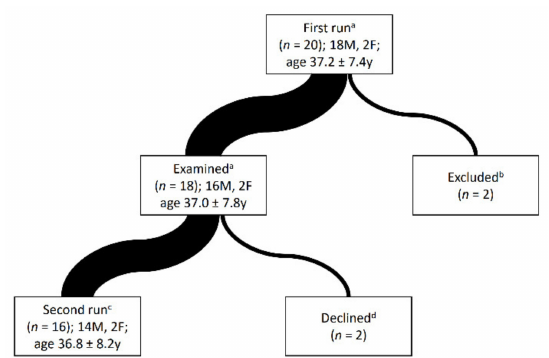
Figure 1. The structure of the study group. a The blood and urine analyzed; 16 completed the run (100 km); 2 completed half of the run (51 km); b Two runners were excluded from the study. The first one due to withdrawal after 30 km the second one due to technical problems with blood collection; c The blood and urine analyzed; all runners completed the run (10 km); d Two runners did not participate in the second race. Their results from 100 km run were not